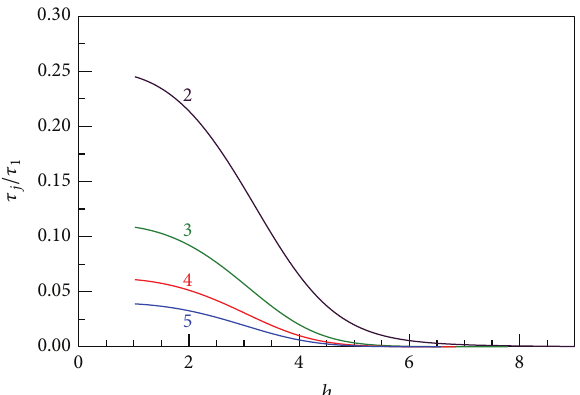
Figure 2: The dependence of the exit neutron count 𝑁 𝑒 /𝑁 0 (11) on the waveguide width ℎ for different values of Φ . The curves are marked by the values of Φ . The experimental data are fitted to the curve with Φ = 23.5 which corresponds to 1D Gaussian roughness with 𝜂 = 0.19 and 𝑟 = 1.19